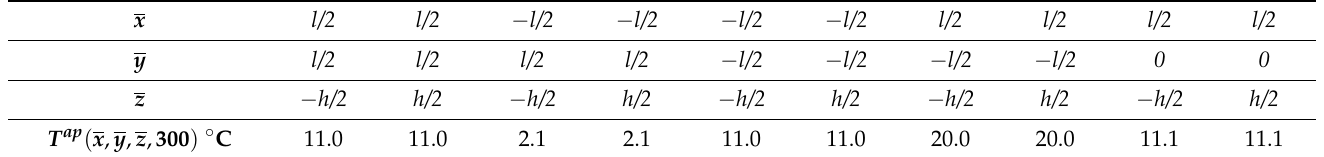
Figure 3. Temperature fields in the copper plate obtained at z = 0 and for T c = 31 ◦ C, v a = 4.5 m/s, at different moments in time. Table 7. Temperatures in the corners of the copper plate and at the midpoint of the plate’s surface facing the heated air inlet to the room for T c = 1 ◦ C, v a = 4.5 m/s, and t = 300 s.